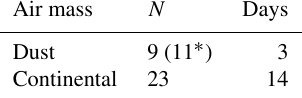
) mea- 1064nm ) re- 1064nm